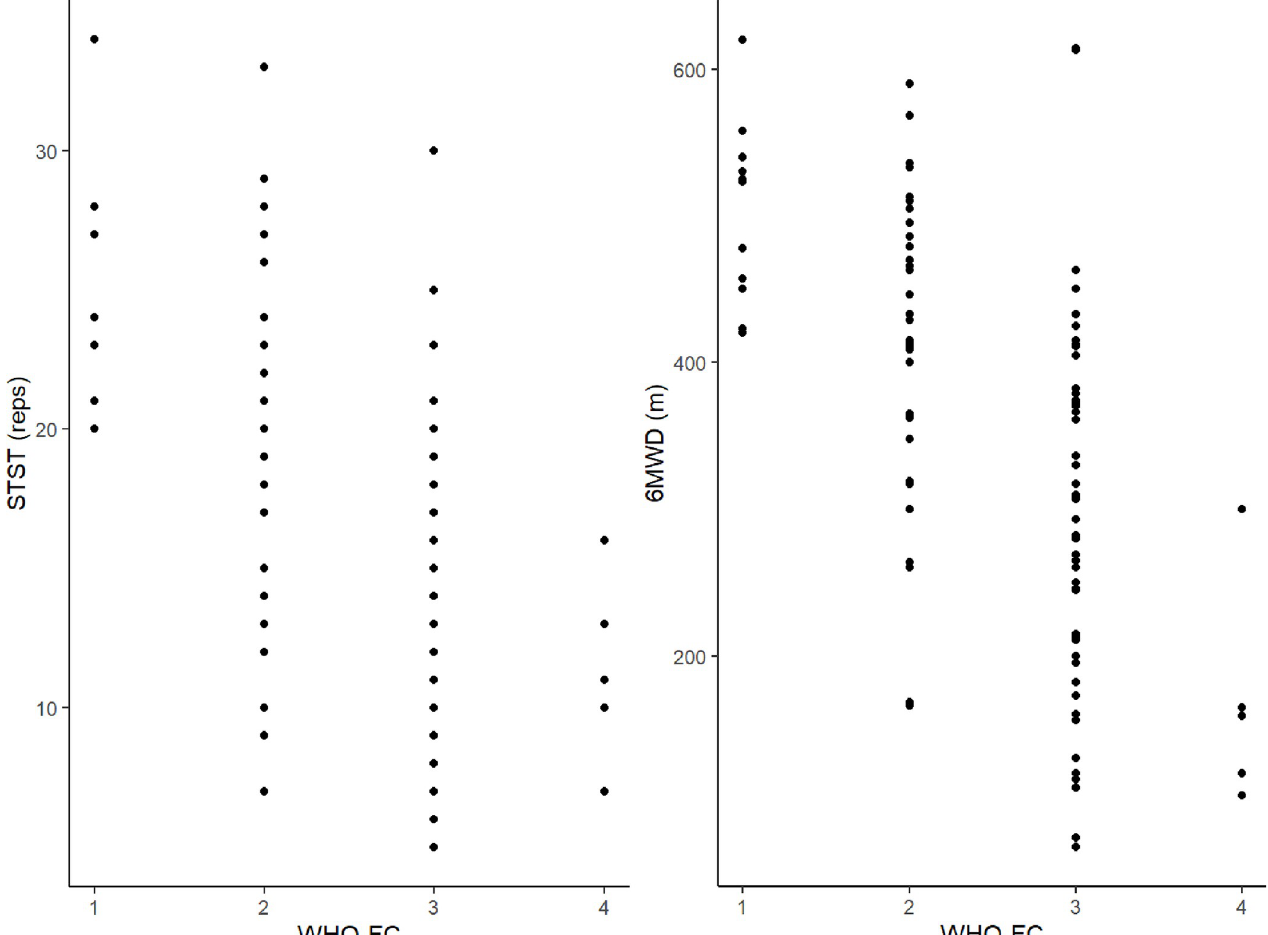
Fig 2. 1-min STST and 6MWT performance in relation to WHO functional class. Abbreviations . 1-min STST = one-minute sit-to-stand test; reps = number of repetitions; 6MWD = six-minute walk distance, WHO-FC = World Health Organization functional class; STST = sit-to-stand